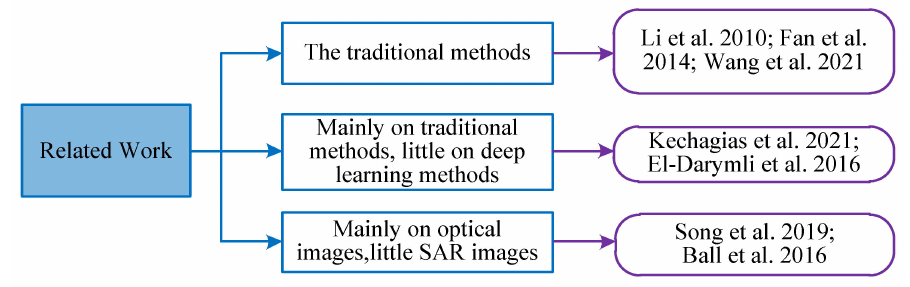
Figure 3. The related work [9,11–16].